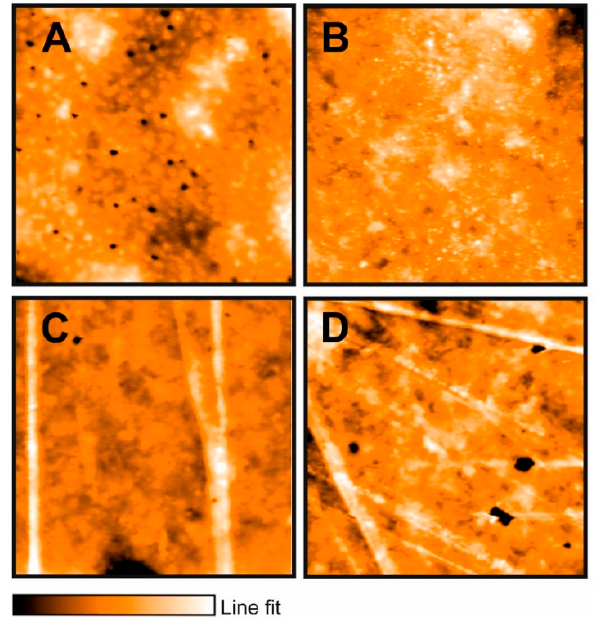
Figure 2. Representative atomic force microscopy (AFM) images of ( A ) starch ( B ) starch/bentonite, ( C ) starch/bentonite/Mexican oregano ( Lippia berlandieri Schauer) essential oil 1%, and ( D ) starch/bentonite/Mexican oregano ( Lippia berlandieri Schauer) essential oil 2%. Conditions: Static force, set point 55 nN. Area: 50 × 50 μ m. Line fit (color intensity) shows the vertical profile of the sample. The lightest region is the highest point, and the dark region corresponds to depressions in the material: ( A ) 0.26 μ m, ( B ) 0.17 μ m, ( C ) 0.464 μ m, and ( D ) 0.3 μ m.